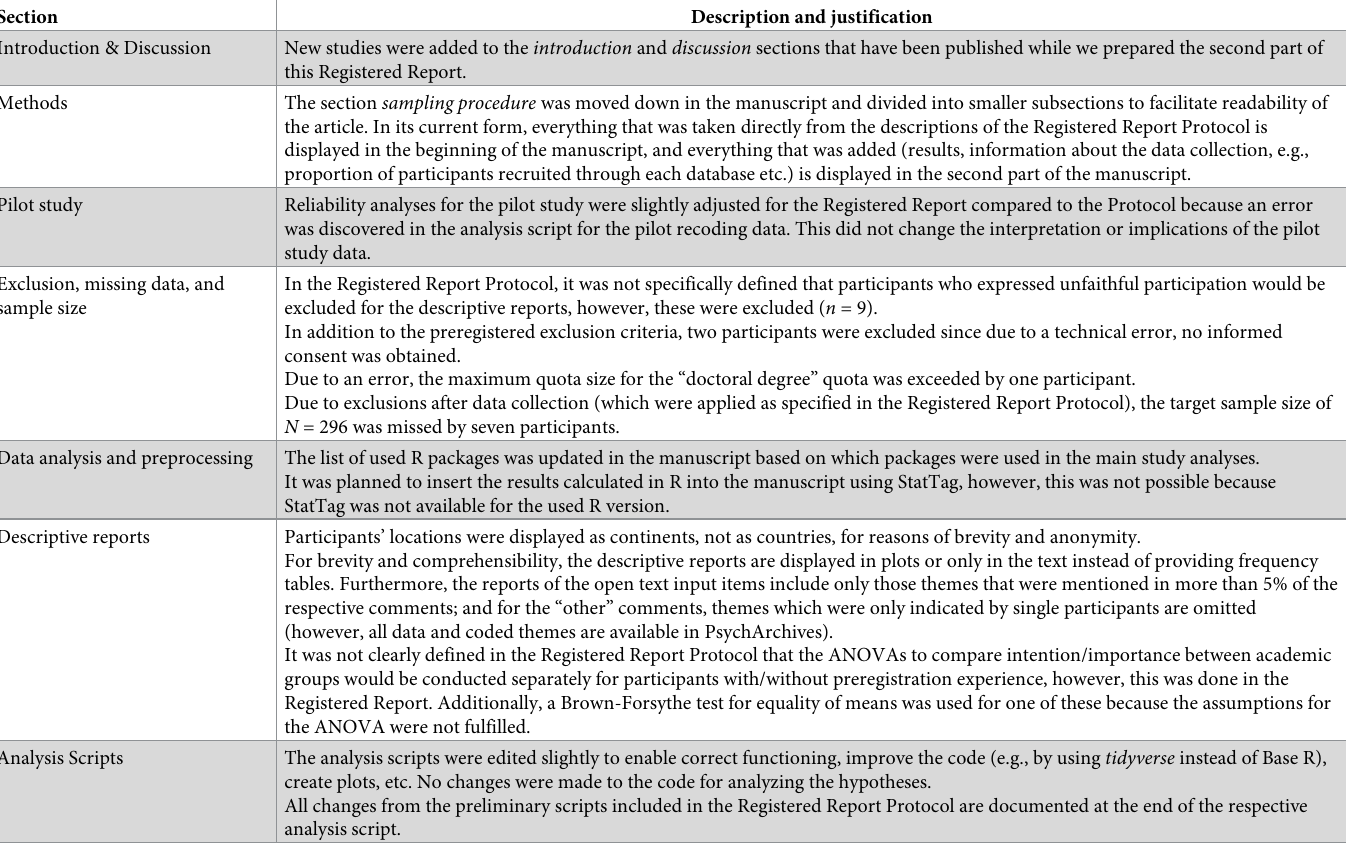
Table 1. Deviations from the preregistered